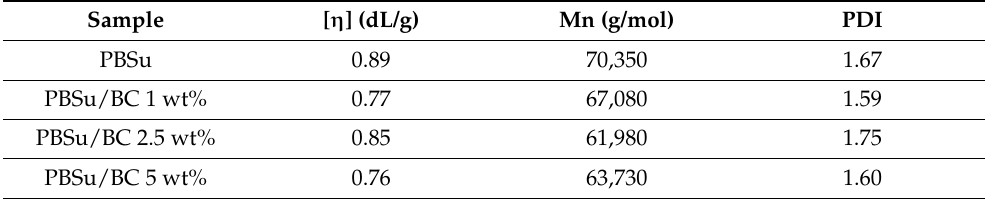
Table 1. Intrinsic viscosity and molecular weight of the prepared PBSu and its biocomposites. Sample